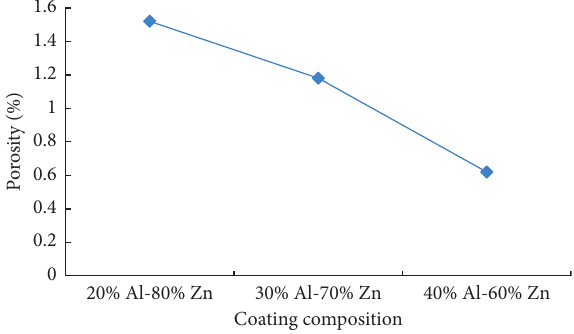
Figure 5: Porosity variation of the three coatings. Figure 6: Schematic diagram of the hardness testing